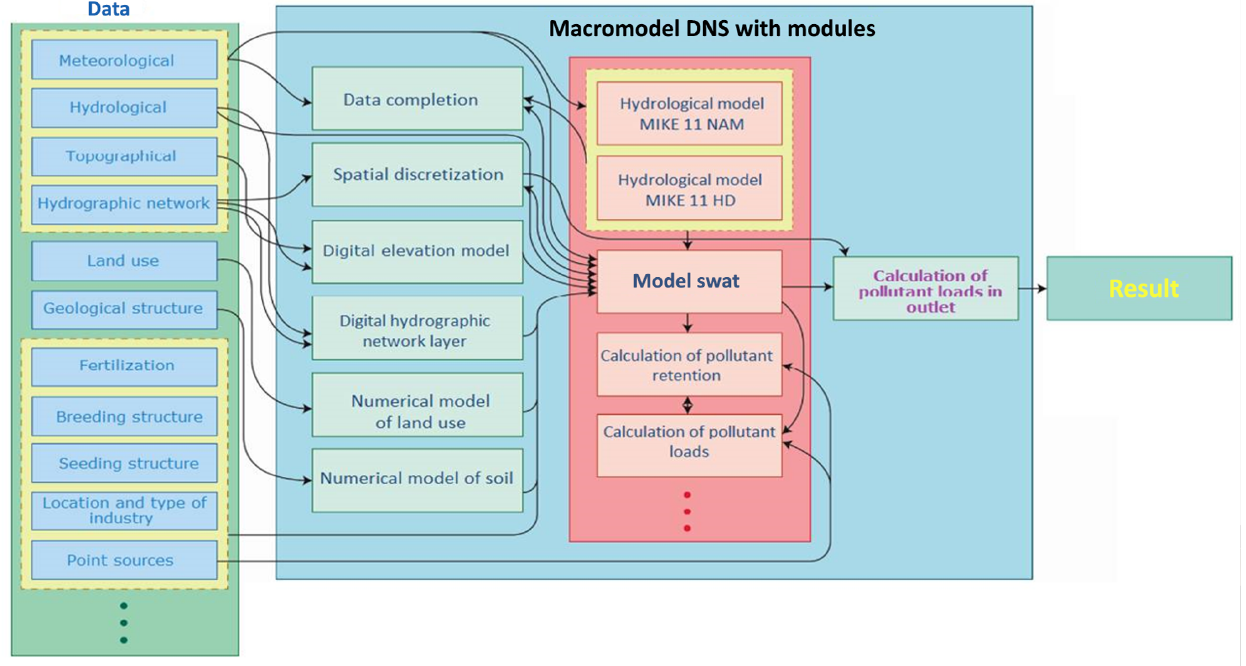
Figure 4. Macromodel DNS/SWAT schematic diagram (source: Ostojski, 2012).